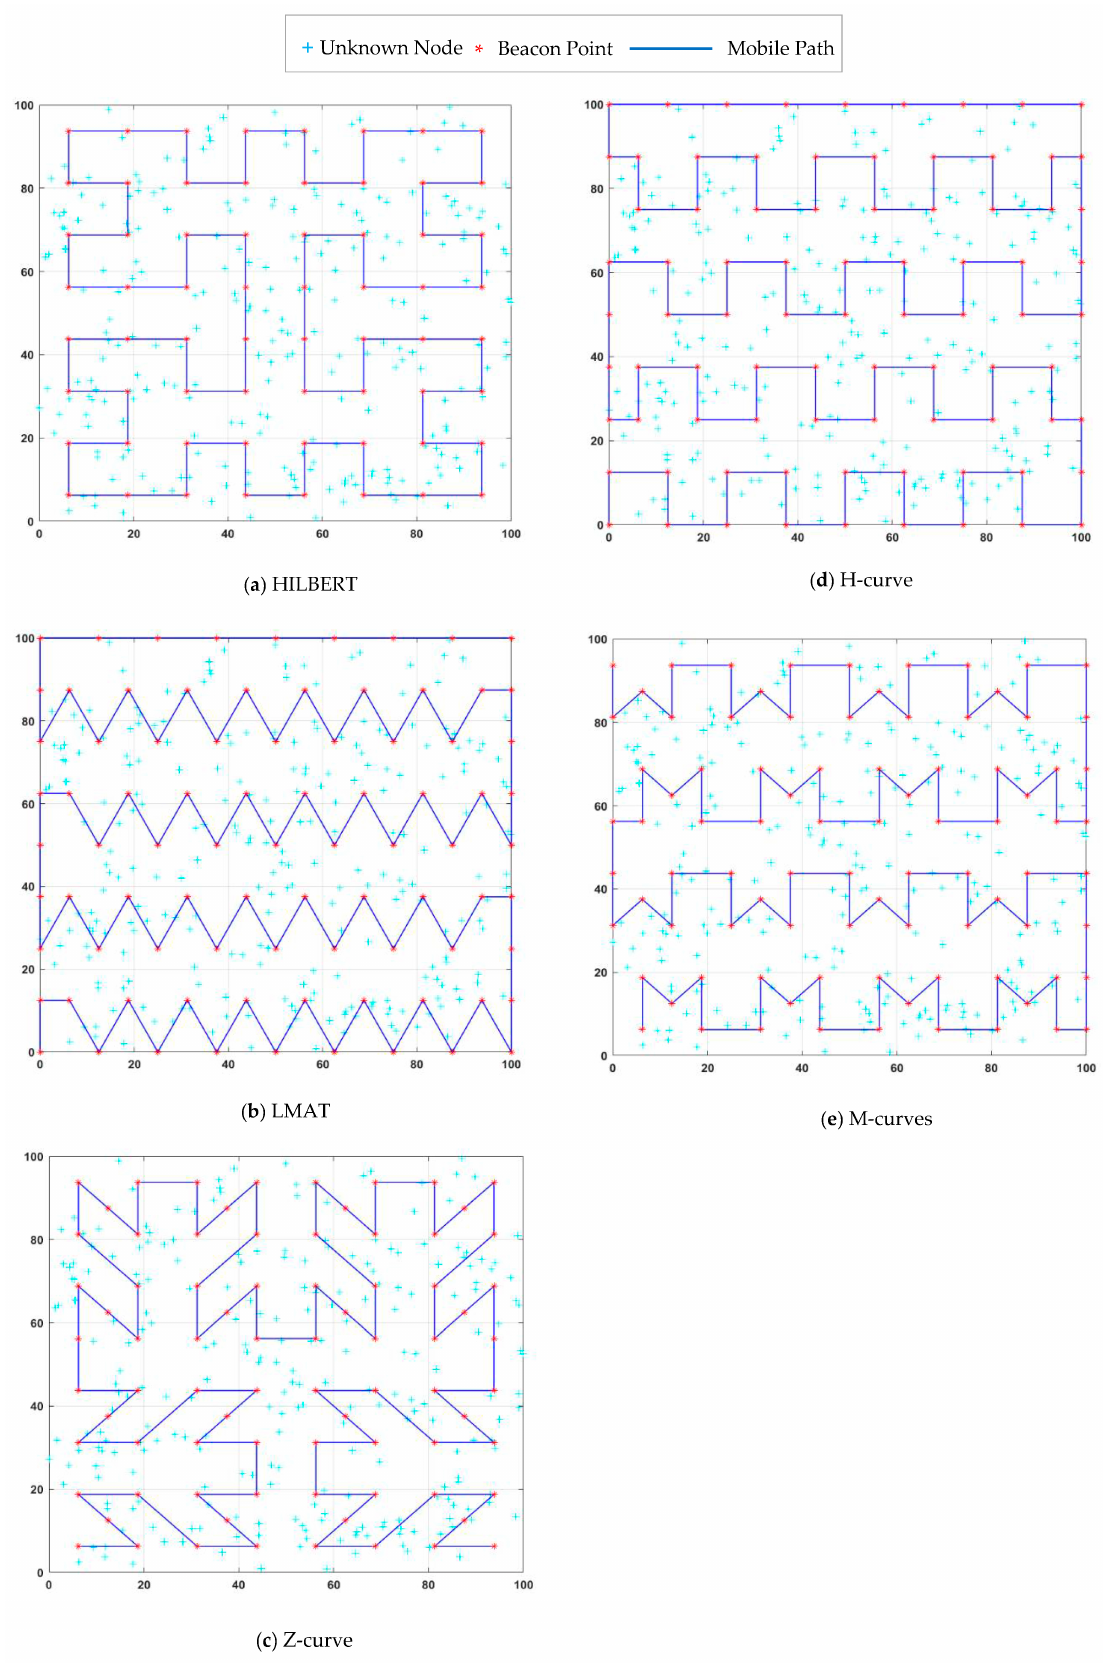
Figure 4. Different mobile path planning models in obstacle-free field.